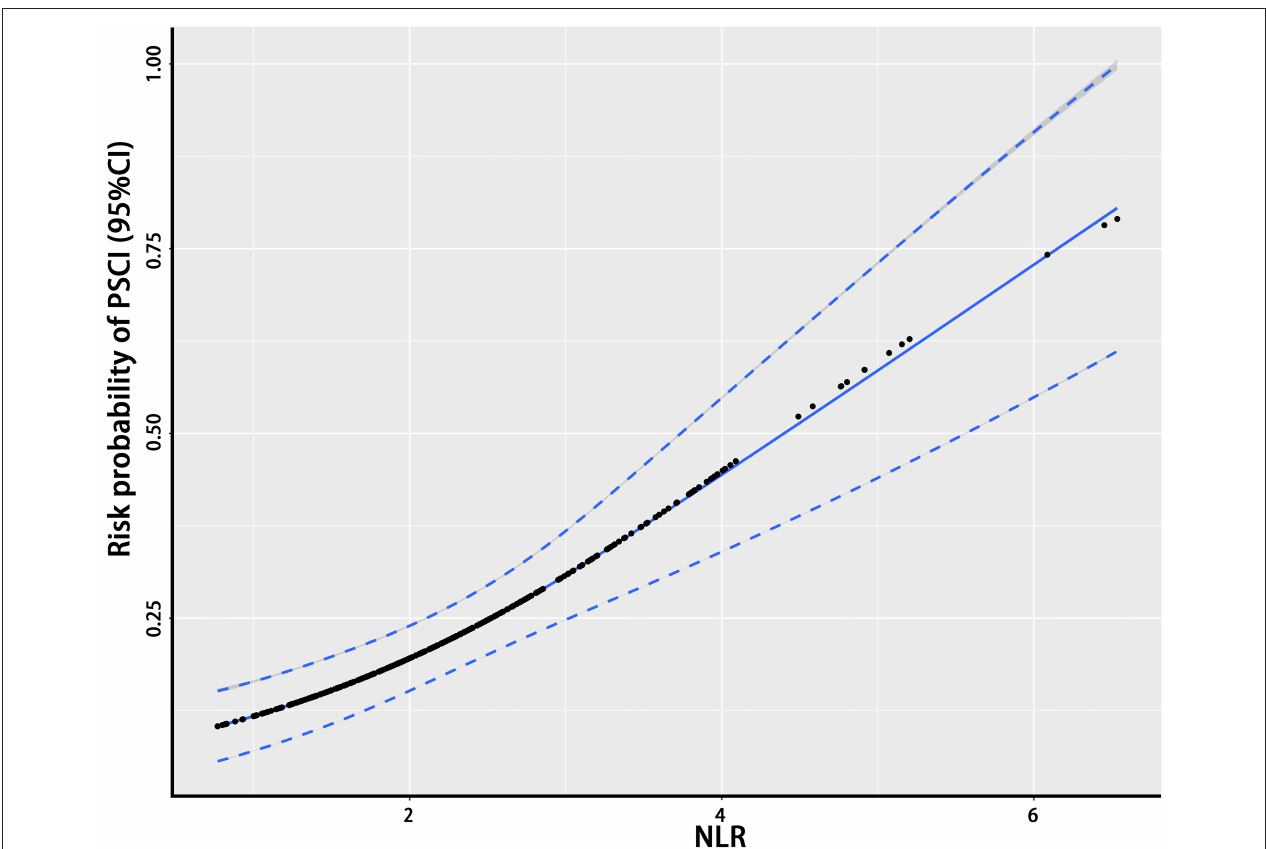
FIGURE 1 | The relationship between the NLR and the probability of PSCI. This figure shows the association between the NLR and the probability of PSCI. The black dots represent the probability of the occurrence of PSCI corresponding to the given NLR level and the blue curves on either side are their 95% confidence intervals. NLR, neutrophil-to-lymphocyte ratio; PSCI, poststroke cognitive impairment.